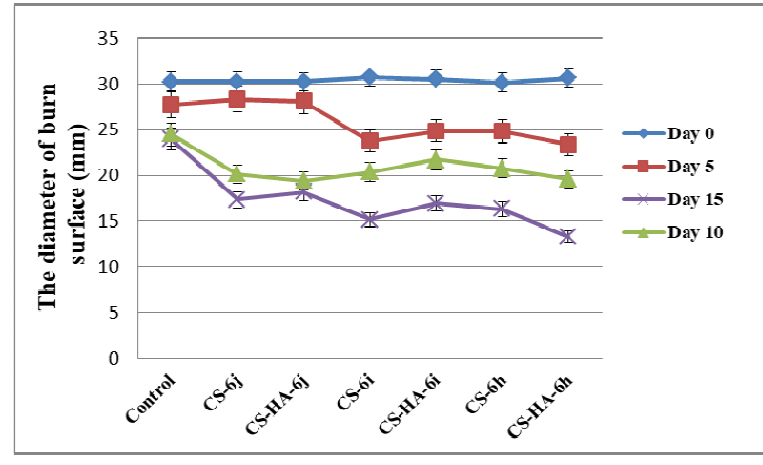
Figure 7. The diameter of burn surface (mm) at different times (CS ‐ chitosan, HA ‐ hyaluronic acid).